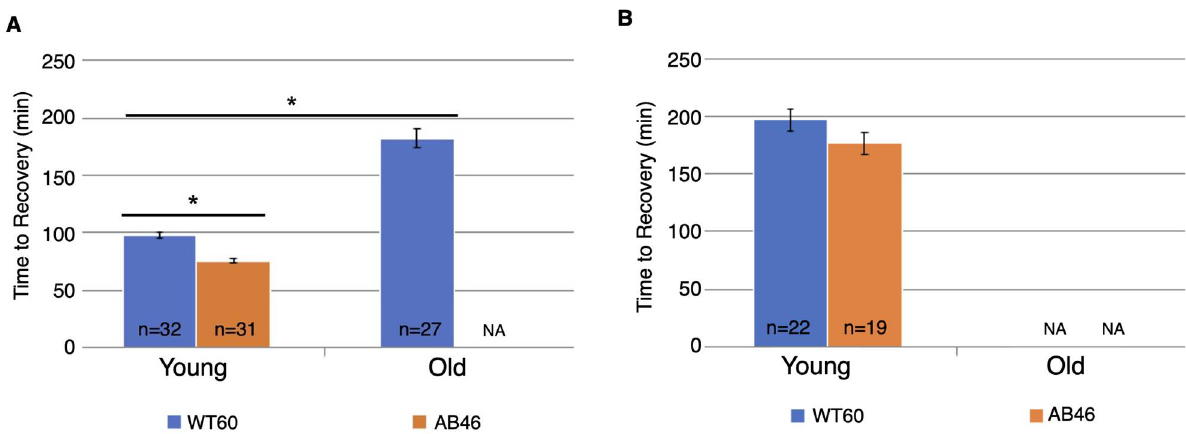
Figure 5. Recovery after prolonged hypoxia. Wild-type (WT60) and MSR-deficient (AB46) animals were exposed to three hours ( A ) or six hours ( B ) hypoxia using the slow nitrogen flow rate (25 mL/s). After the indicated time of hypoxia, the animals were returned to normal atmosphere and allowed to recover from the spreading depression coma. Recovery was scored as the first movement detected by the Drosophila Activity Monitor. The number of individual animals ( n ) used for each age-group and genotype is shown on the graph. NA indicates that none of the test animals survived the hypoxic treatment. Error bars are the SEM. Significance is indicated by an asterisk where p < 0.0001 using an unpaired t -test.